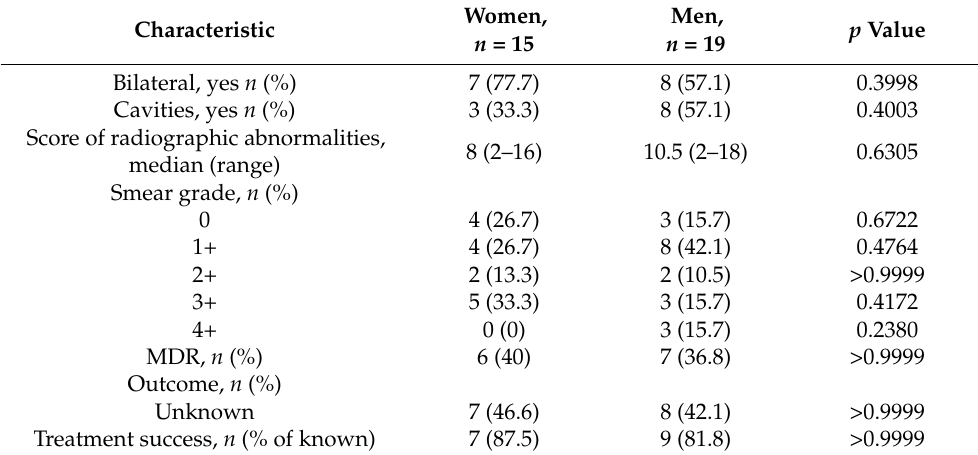
Table 2. Severity of the disease.